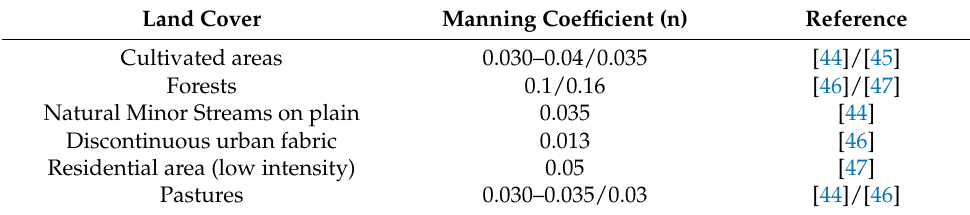
Table 3. Manning roughness coefficient values according to land cover.